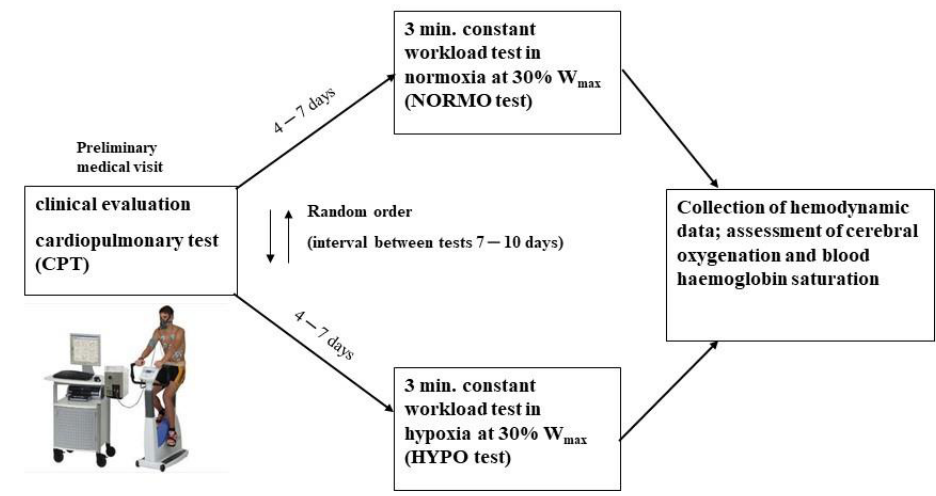
Figure 1. Schematic representation of the experimental protocol.